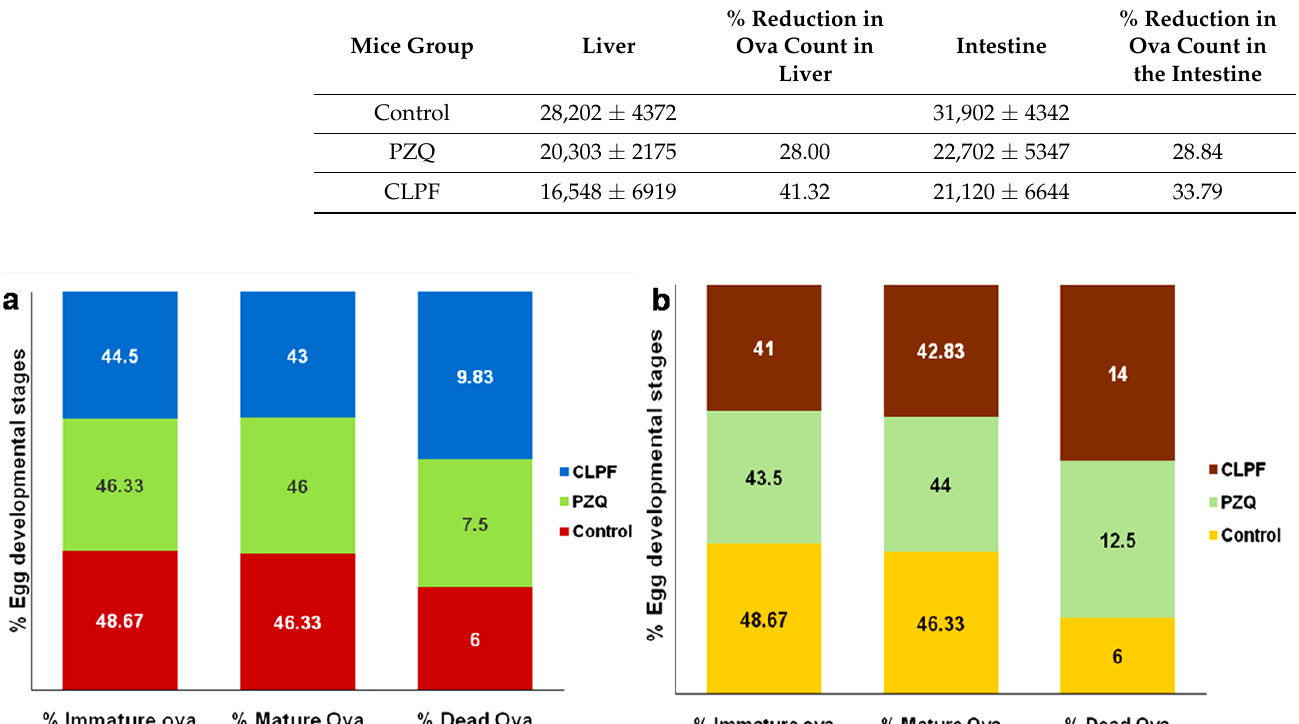
Table 4. Effect of PZQ and CLPF (single dose 250 mg/kg two weeks post-infection) on number of ova/gm tissues in S. mansoni -infected mice euthanized six weeks post-infection.